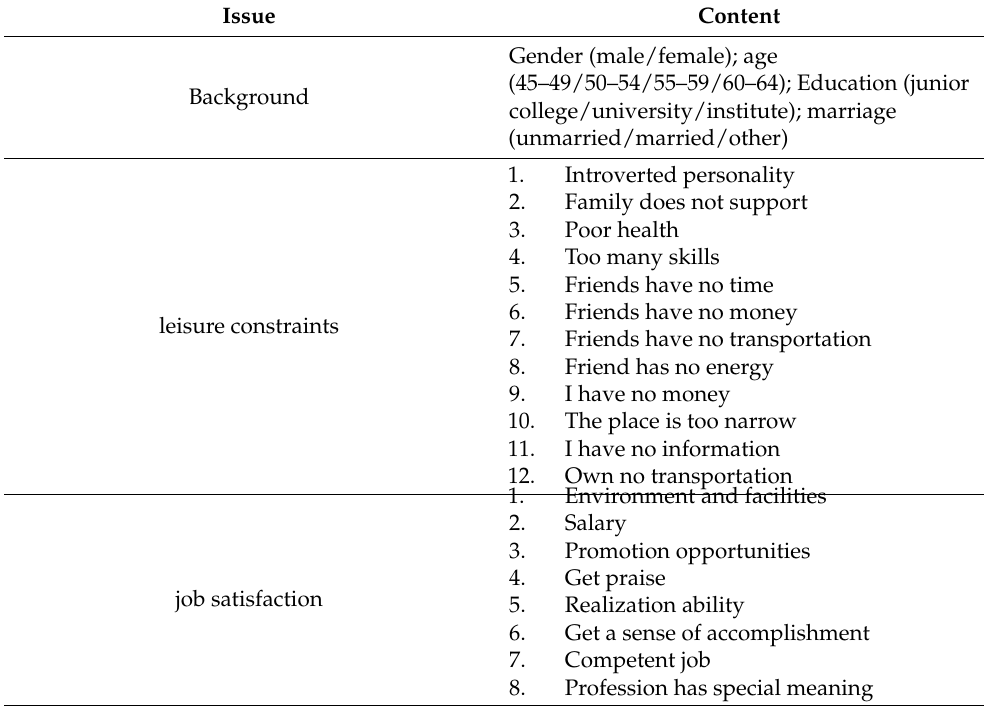
Table 1. Questionnaire tool description for leisure constraints and job satisfaction of middle-aged and elderly health care workers.